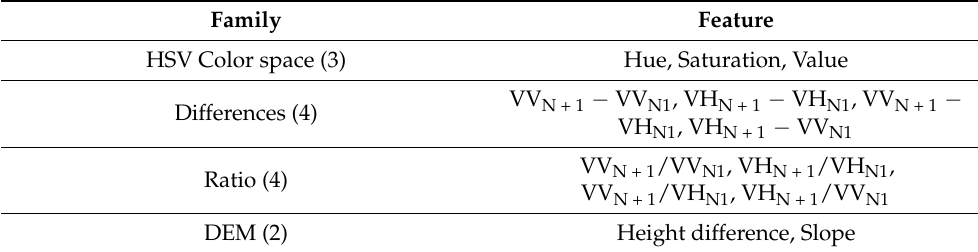
Table 4. Feature set for RF algorithm acquired from multi-source